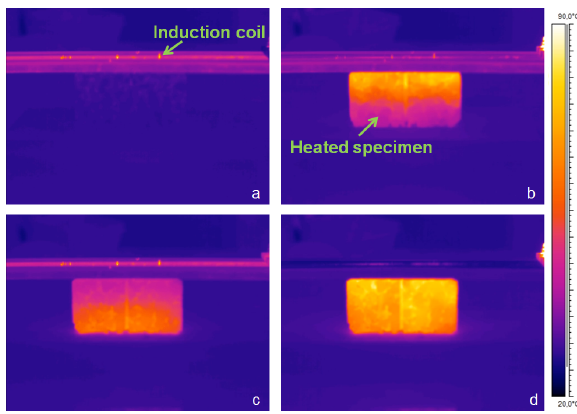
Figure 4. The healing process of SCB specimens: (a) heating start on one side; (b) one side heating complete; (c) Turn over and start heating on the other side and (d) the whole heating process complete. Figure 5. (a) Peak load of SCB specimens and (b) induction healing index of SCB